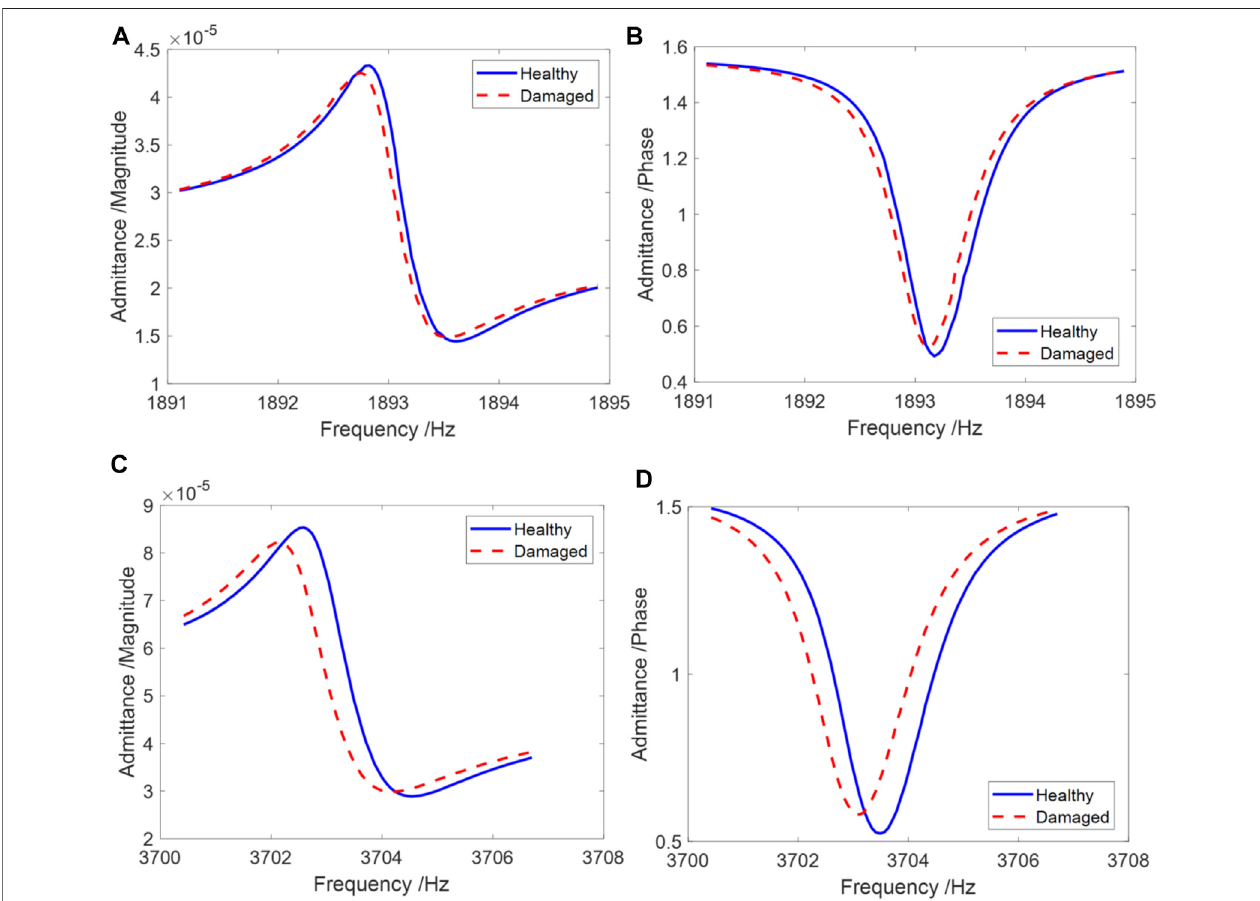
FIGURE4| Admittancemeasurementsovertwofrequencybands. (A) Magnitude(lowerfrequencyband); (B) phase(lowerfrequencyband); (C) magnitude(higher frequency band); and (D) phase (higher frequency band).